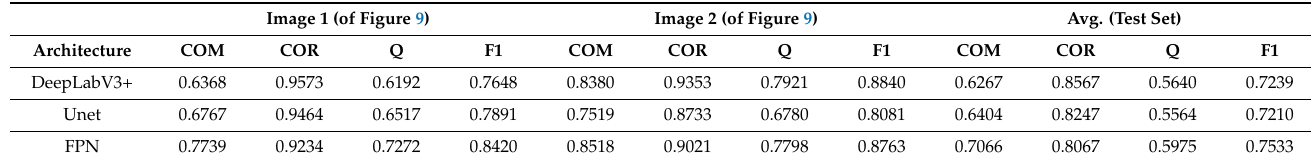
Table 1. Road region detection quantitative results.